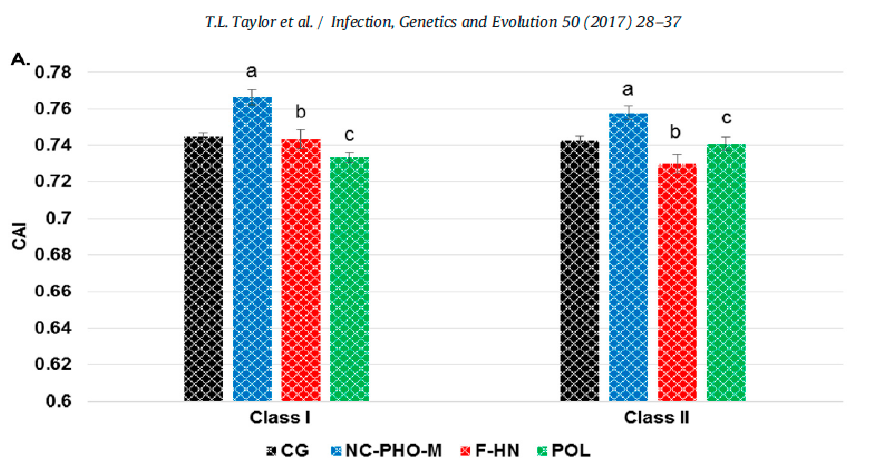
Figure 2. Codon usage adaptation in genomes of class I and II viruses. Excerpts from Figure 2 in Taylor, T.L.; Dimitrov, K.M.; Afonso, C.L. Genome-wide analysis reveals class and gene-specific codon usage adaptation in avian paramyxoviruses 1. [62]. Avian paramyxoviruses 1 display differences in codon usage between the three transcriptional genomic regions. A) The average codon adaptation index (CAI) value for the complete genome and each genomic region (NC-PHO-M, F-HN, and POL) for class I ( n = 29) and class II ( n = 259) viruses was determined using Gallus gallus as a reference genome. The complete genome result is in black, NC-PHO-M is in blue, F-HN is in red, and POL is in green. Standard error bars are shown, and statistically significant differences between the same regions between classes are shown (Pb 0.01) with corresponding